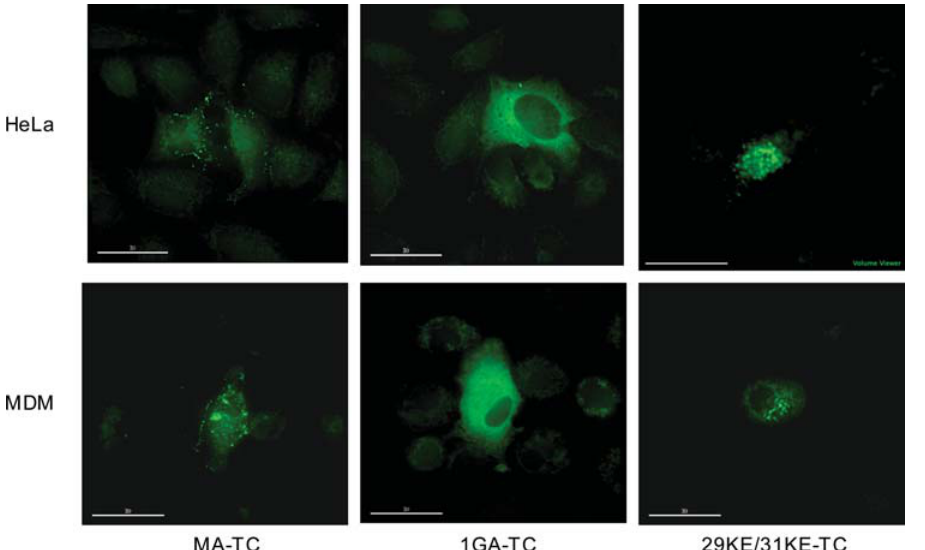
Figure 2. The MA-TC tag does not affect Gag localization. HeLa cells (top panel) were transfected with pNL4-3/MA-TC or 1GA or 29KE/31KE derivatives. Cells were labeled with FlAsH for 5 min at 37 u C, washed, fixed in 3.7% formaldehyde, and examined microscopically. MDMs (bottom panel) were infected with VSV-G- pseudotyped virus stocks that transduced NL4-3/MA-TC or 1GA or 29KE/31KE derivatives (see Materials and Methods). Infected cells were labeled and fixed as described above. Scale bars=30 m m. For a 3D z-series of the 29KE/31KE-TC mutant in MDM, see Video S1.